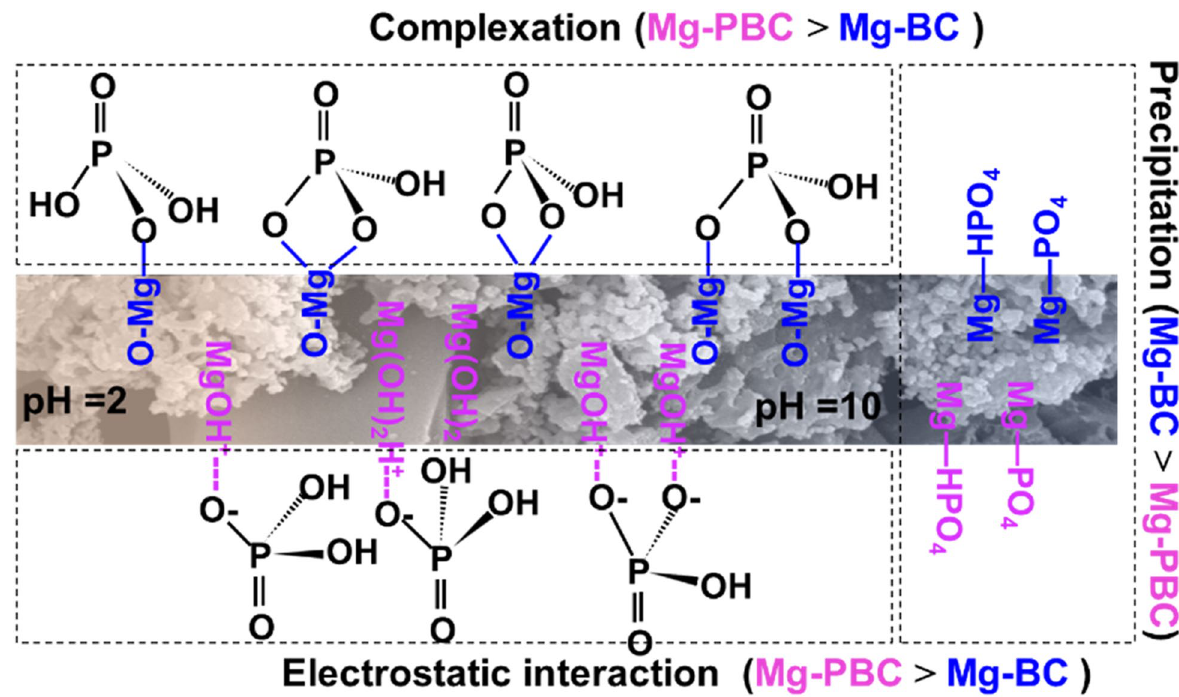
Fig. 7 Mechanism diagram of MgCl 2 impregnation promotion by pre-puffing and P adsorption on MgO